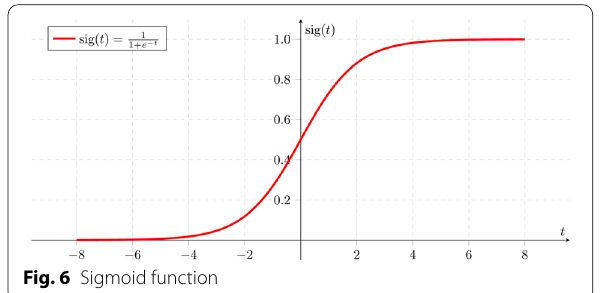
Fig. 6 Sigmoid function